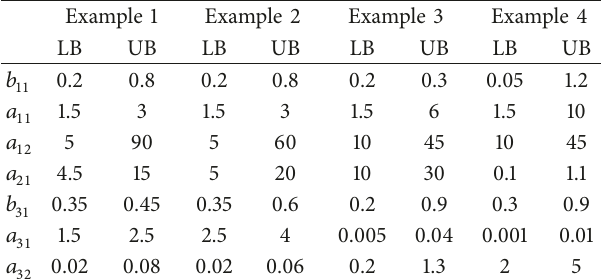
Table 2: Search regions of the genome variables.